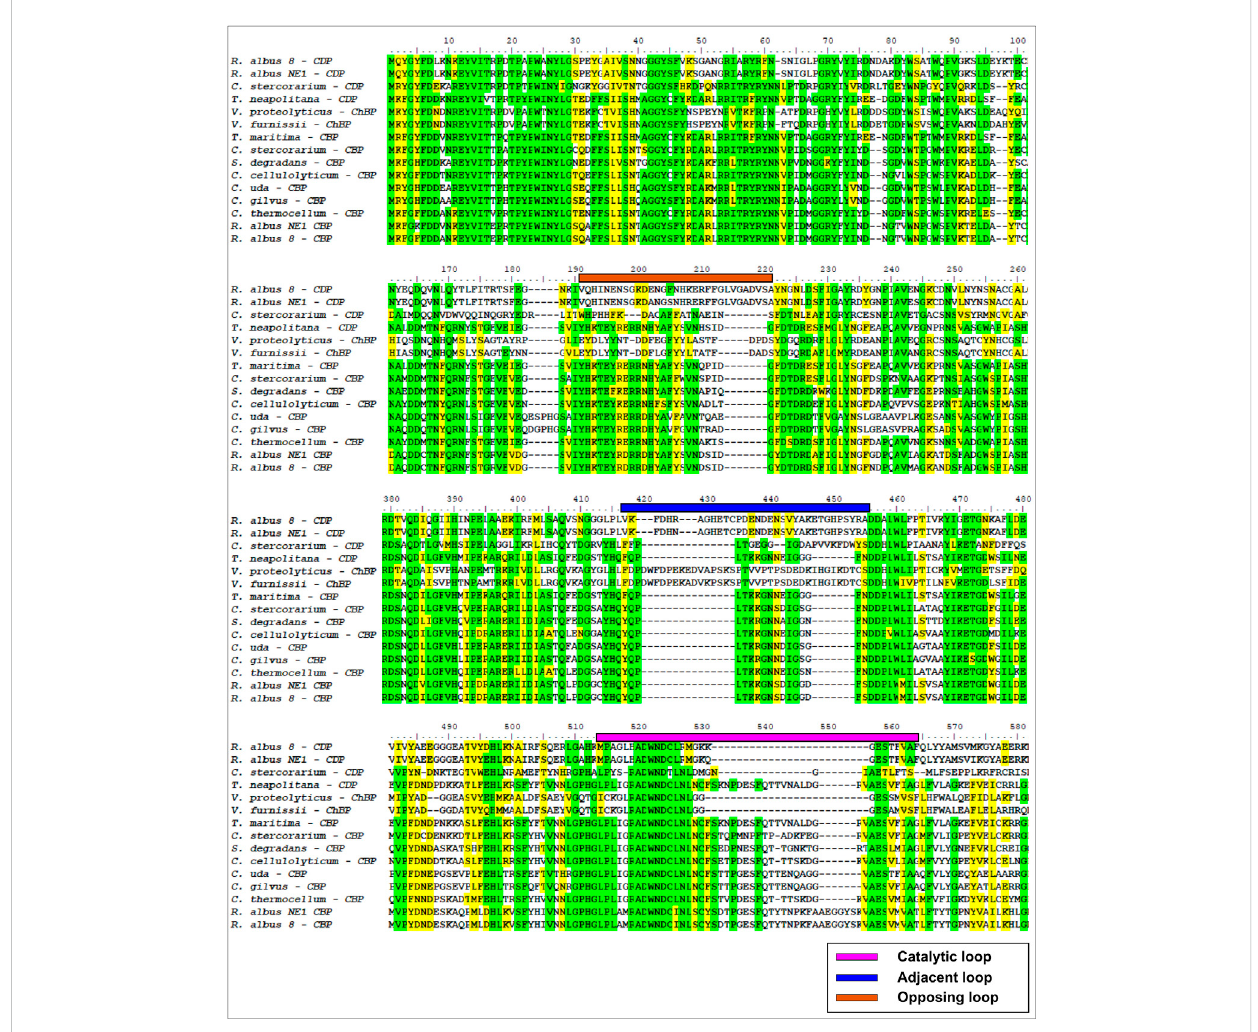
FIGURE 1 Multiple alignment of partial sequences from GH94 family enzymes. Color lines over the sequences delimit opposite (orange), adjacent (blue), and catalytic (magenta) loops.